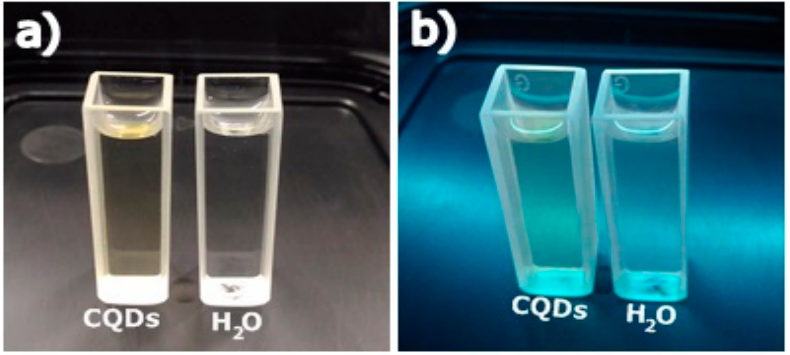
Figure 10. Tyndall effect in a colloid containing carbon nanoparticles.